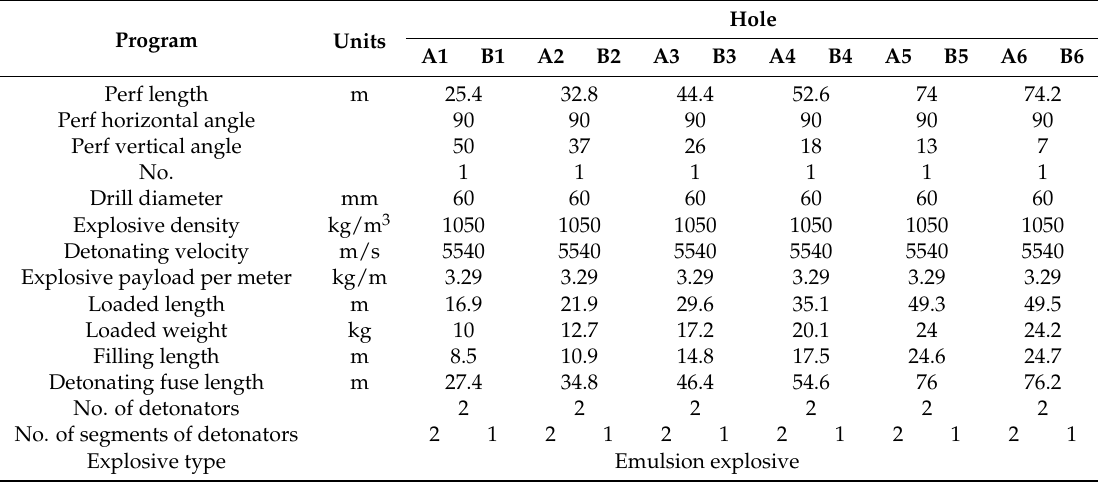
Table 3. Blasting parameters for practical